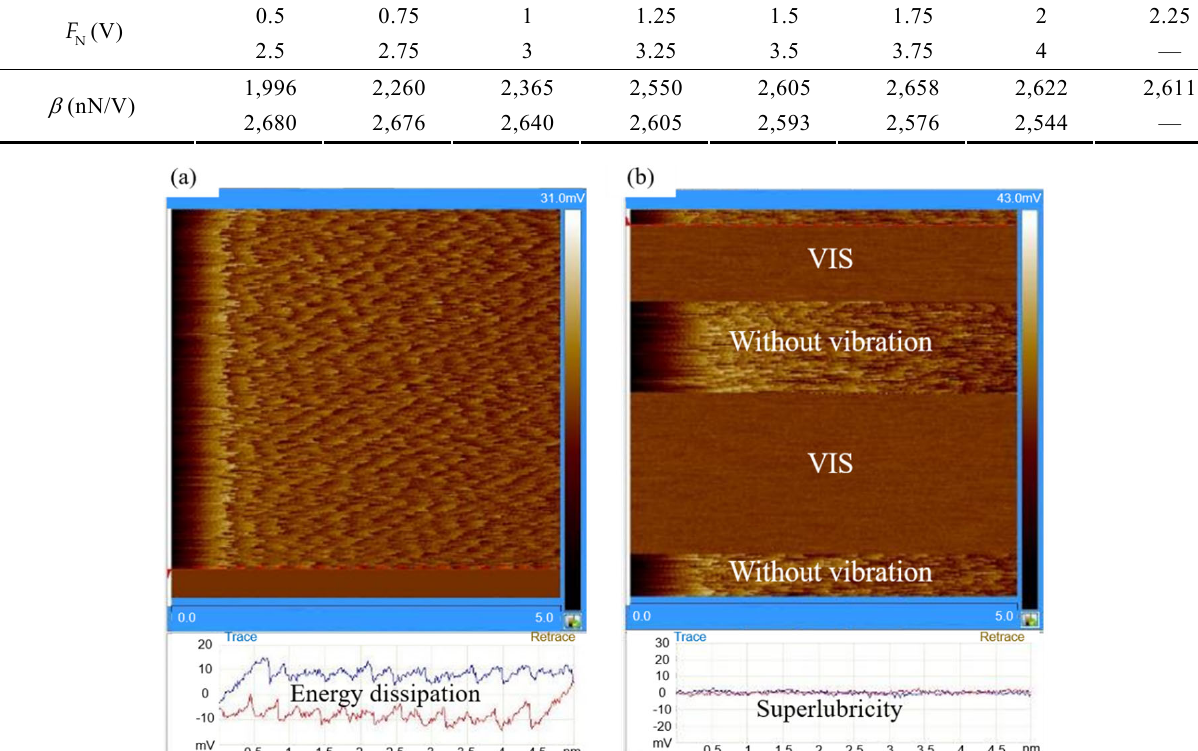
Fig. 7 Friction images detected by scanning forward and backward on an atomically flat HOPG surface: (a) Without z -directional vibration and (b) a comparison between z -directional vibration and no vibration